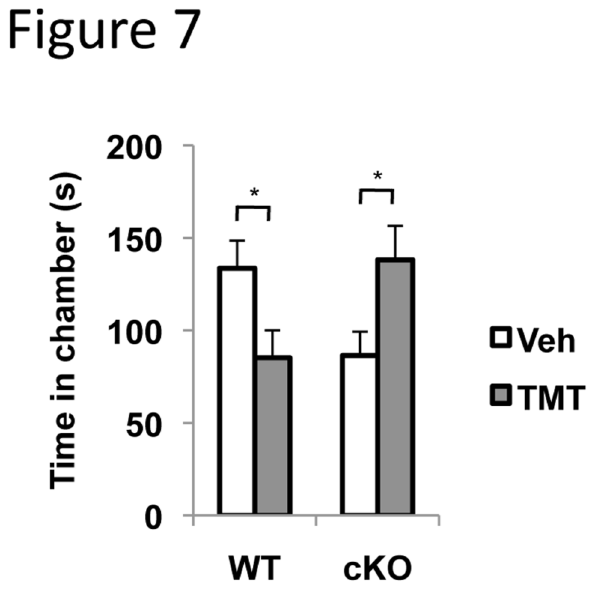
Figure 7. ERK5 cKO male mice do not show innate-fear avoidance towards TMT. Male ERK5 cKO mice and their WT littermates were introduced into the middle chamber of a three- chamber shuttle box with vehicle (Veh) or 1 mM TMT, a predator odor, placed in the either of two end chambers separately. Time spent in each chamber was quantified. *, p<0.05.